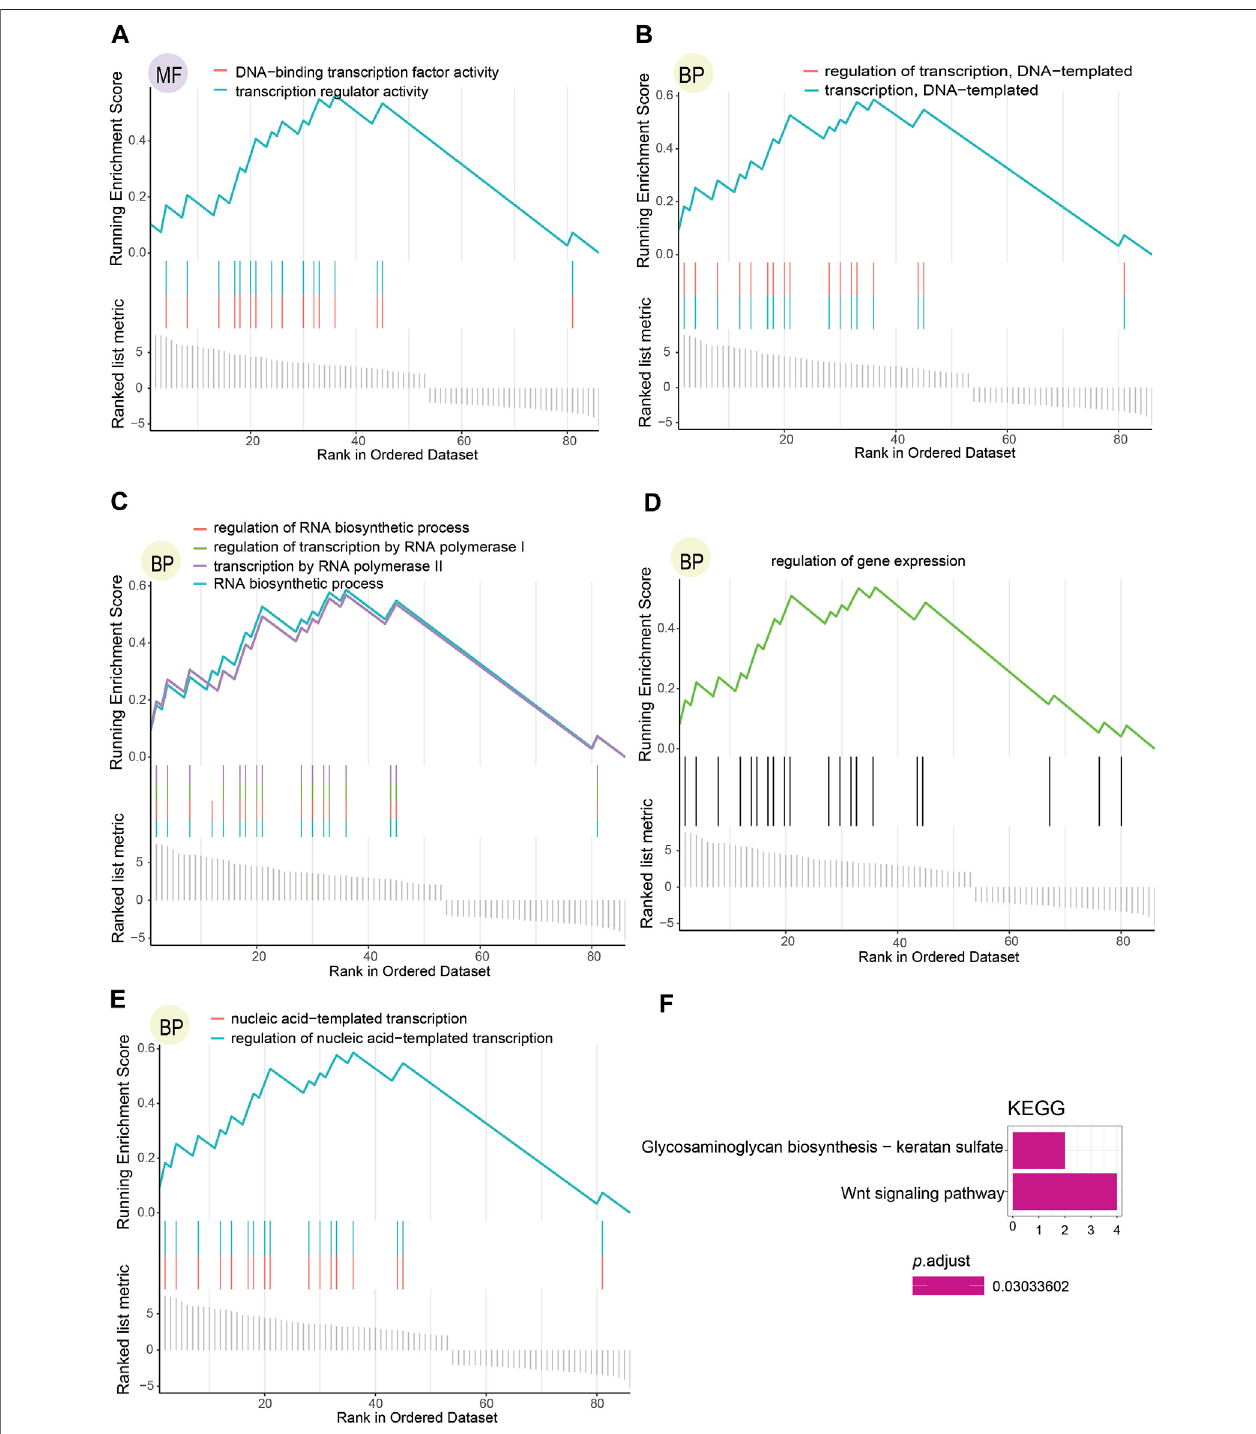
FIGURE 4 | Functional enrichment analysis results regarding DNA methylation-driven genes selected. (A) Consequence of molecular functions with p .adjust < 0.05. (B – E) Outcome of biological processes with p .adjust < 0.05. (F) Result of KEGG pathways with p .adjust < 0.05.